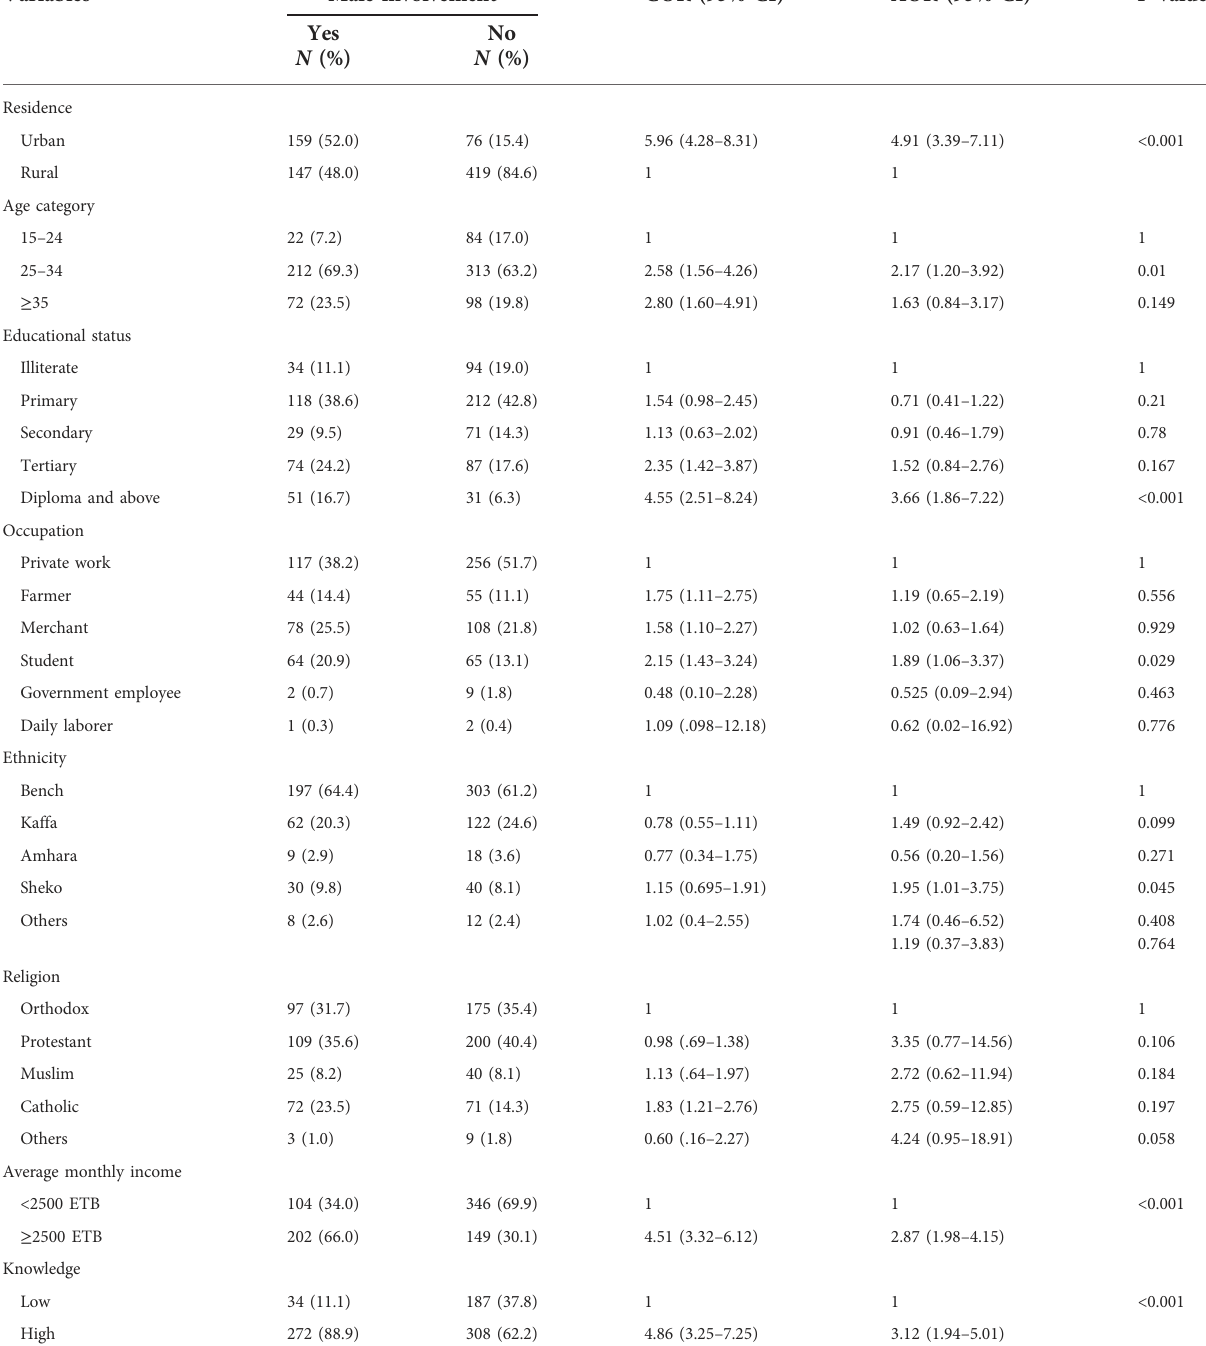
TABLE 4 Multivariate associations of male involvement in ANC in the Bench Sheko zone, southwest Ethiopia,